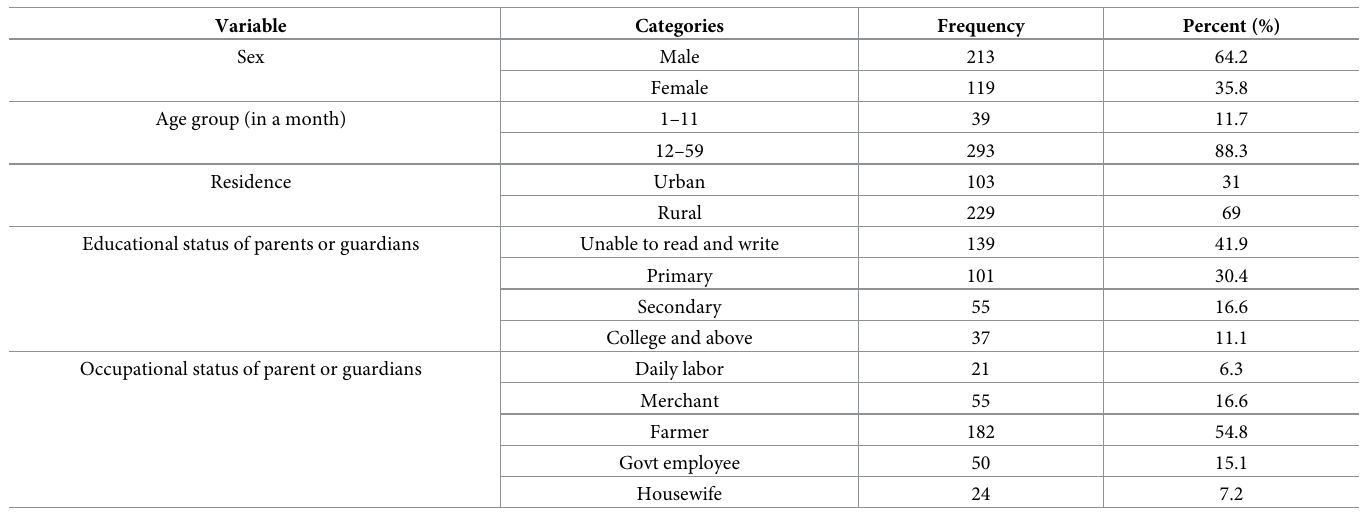
Table 1. Socio-demographic characteristics of under-five children at Hiwot Fana Specialized University Hospitals, eastern Ethiopia, 2021 (n = 332).